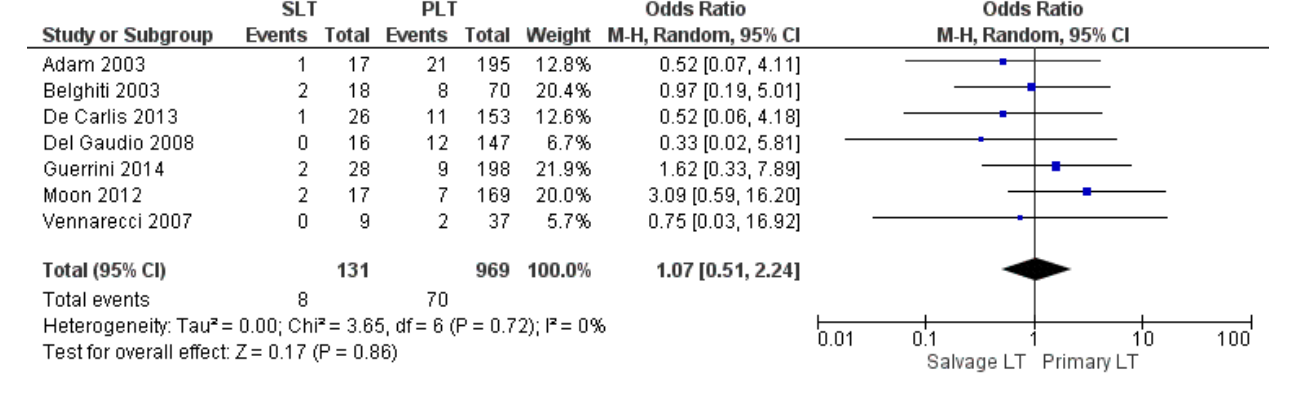
Figure 8. Retransplantation rate.